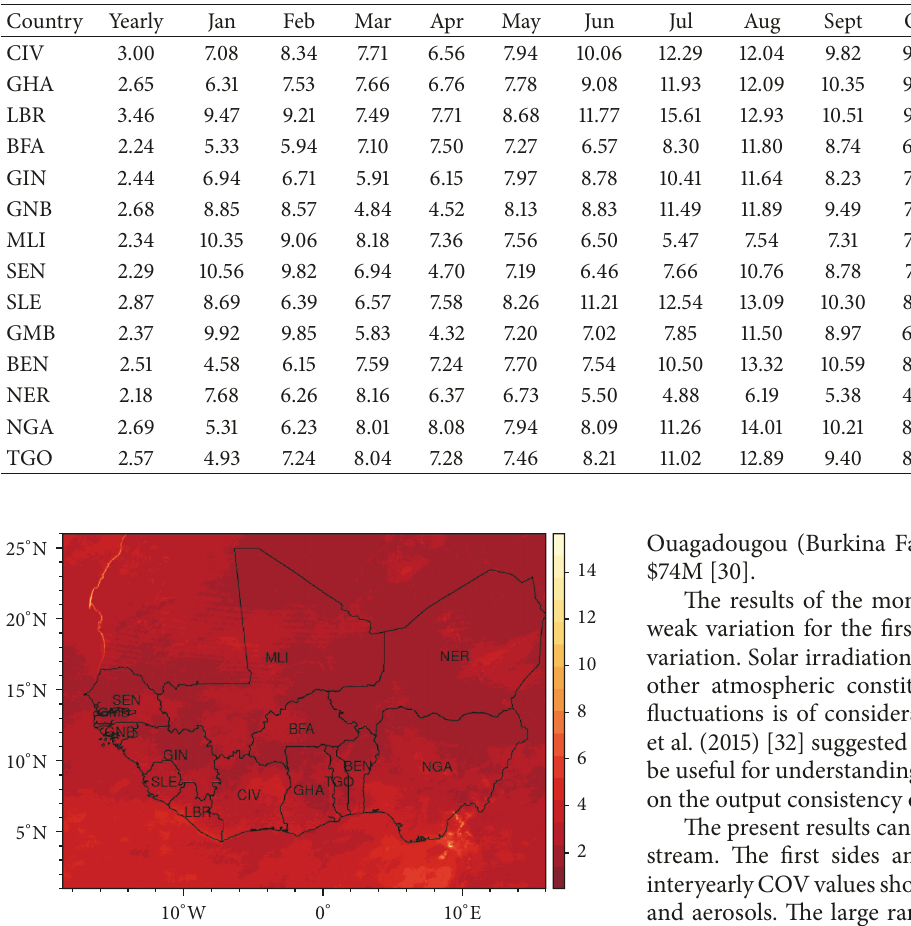
contrast exits between the months of the same year. The COV ranges from 13.48% in Burkina Faso to 23.94% at